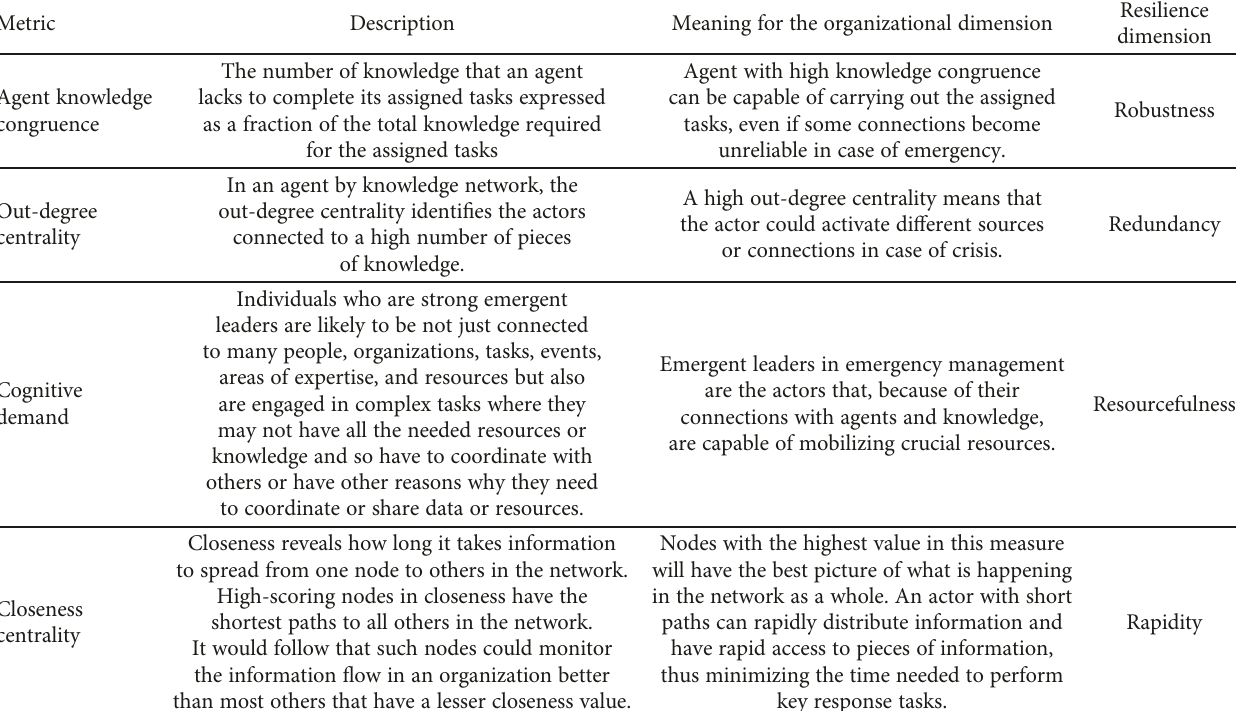
Table 4: GT measures for the analysis of the organizational dimension of